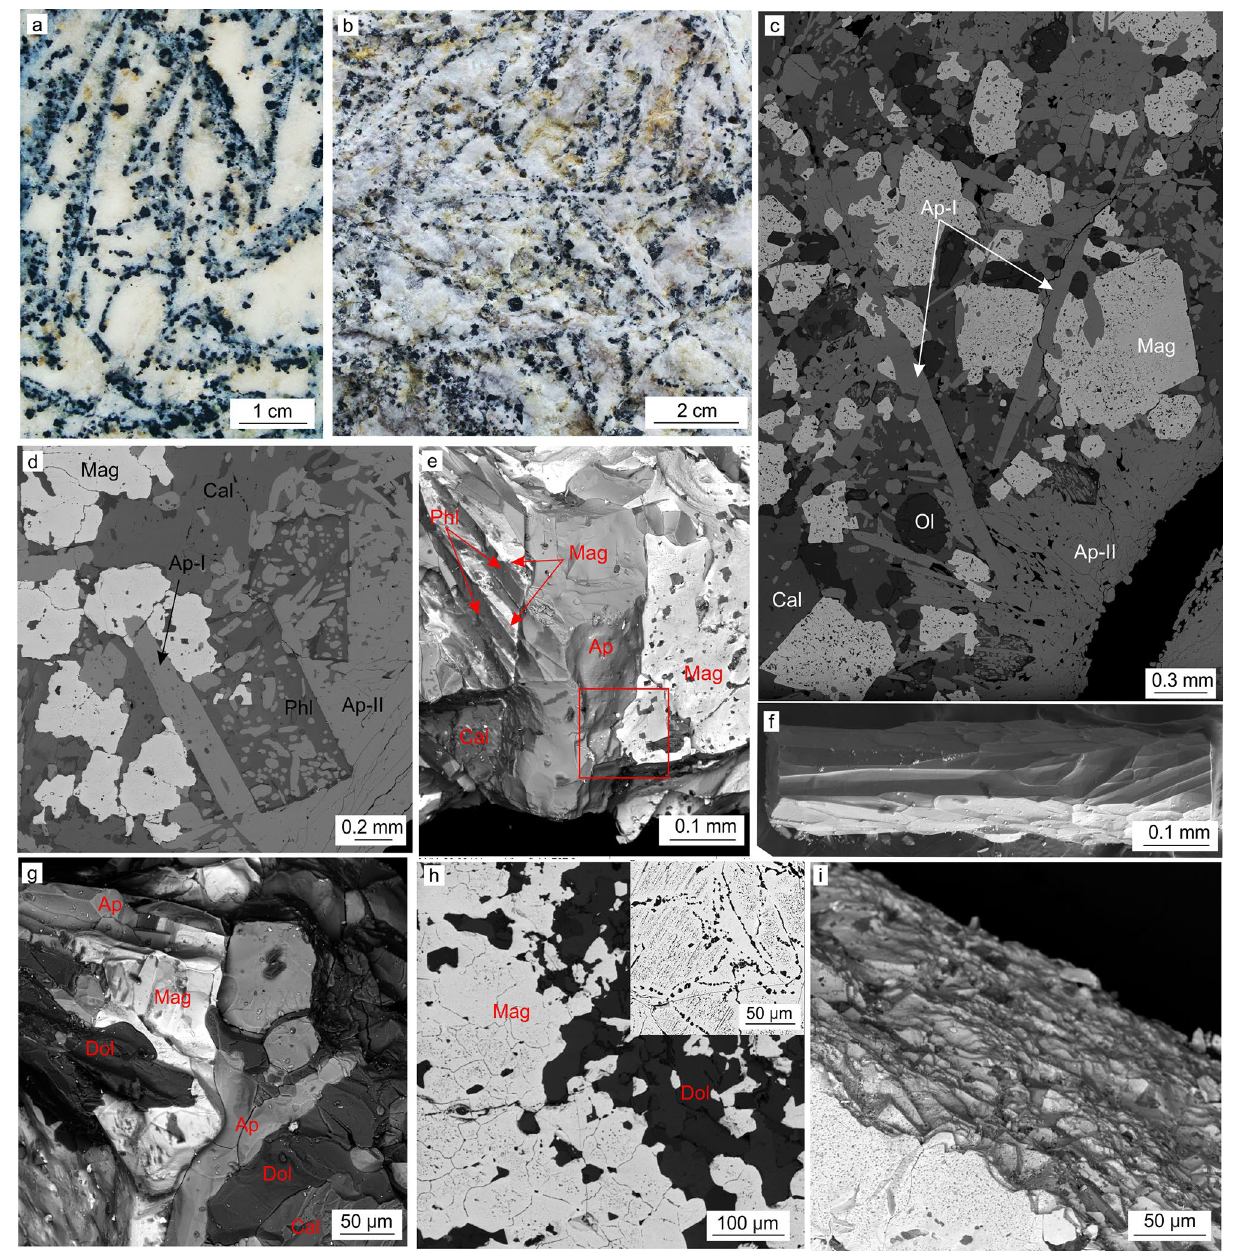
Figure 2. Textural features and mineral relationships of the rocks investigated. ( a ) carbonatite, Guli massif; ( b ) carbonatite, Tagna massif; ( c ) phase relationships, Guli carbonatite (BSE-image); ( d ) phase relationships, Tagna carbonatite (BSE-image); ( e ) apatite-magnetite intergrowth (BSE-image), outlined are intricate apatite- magnetite relationships; ( f ) apatite-II crystal, Guli carbonatite (SE image); ( g ) apatite-magnetite intergrowth, Guli massif (BSE-image); ( h ) multi-domain structure of magnetite, Tagna carbonatite, (BSE-image), corner inset—domains in magnetite grain bordered by trails of spinel inclusions, Guli carbonatite (BSE-image); ( i ) grain surface of a magnetite crystal, Guli carbonatite (BSE-image). Abbreviations: Ap—apatite, Cal—calcite, Phl—phlogopite, Ol—olivine. The figure was created by compilation of SEM photos using Corel Draw